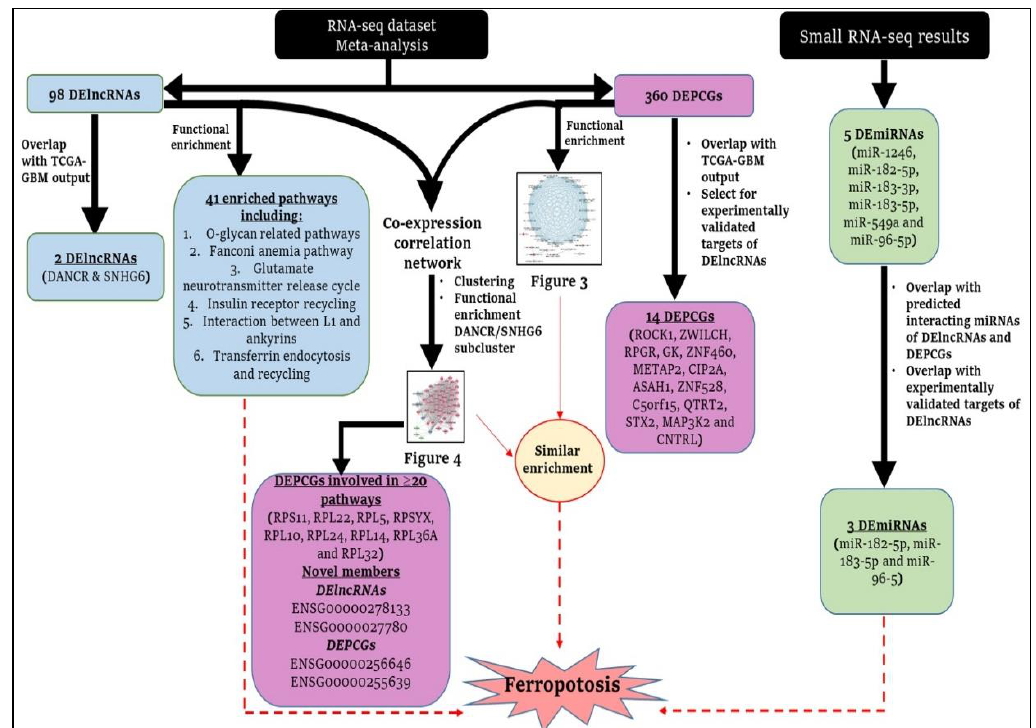
Figure 5. Summary of DElncRNAs (blue), DEPCGs (pink) and DEmiRNAs (green) identified in our study and their connection to ferroptosis.